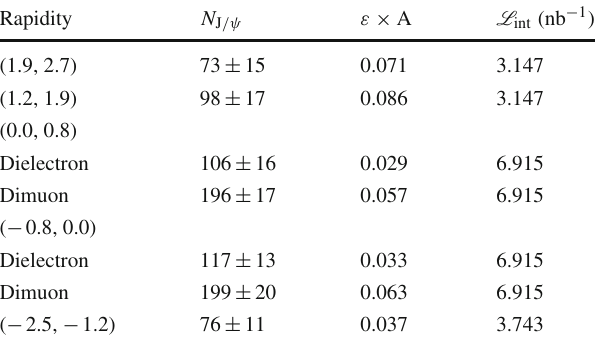
Table 1 Number of measured exclusive J /ψ , value of the efficiency and acceptance correction factor, as well as integrated luminosity for each rapidity interval. These values are used in Eq. (1) to compute the measured cross sections